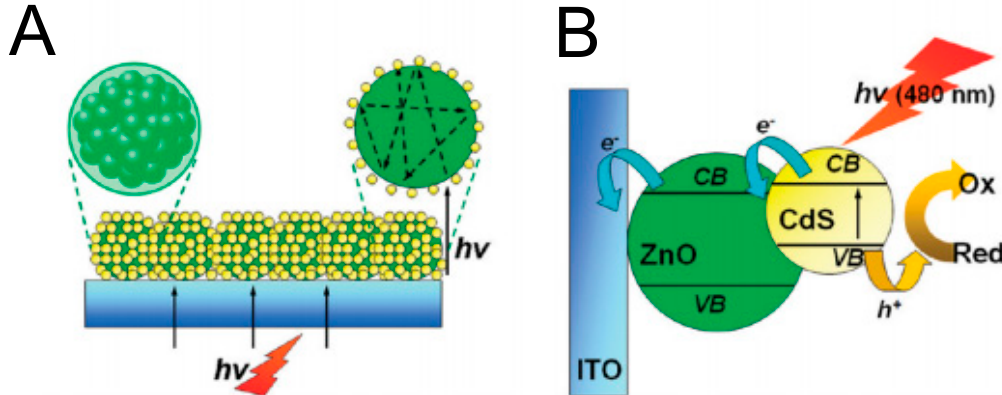
Figure 16. ( A ) Schematic of light scattering occurring on a ZnO/CdS-modified electrode; ( B ) Electron–hole pairs generation, separation, and transfer between ZnO and CdS at a ZnO/CdS-modified electrode for the sensing of Cu 2+ ions where CB and VB are the conduction and valence band. ITO is Indium tin oxide. Adapted figure from [105] with permission from copyright (2011), American Chemical Society, (Washington, DC, USA).